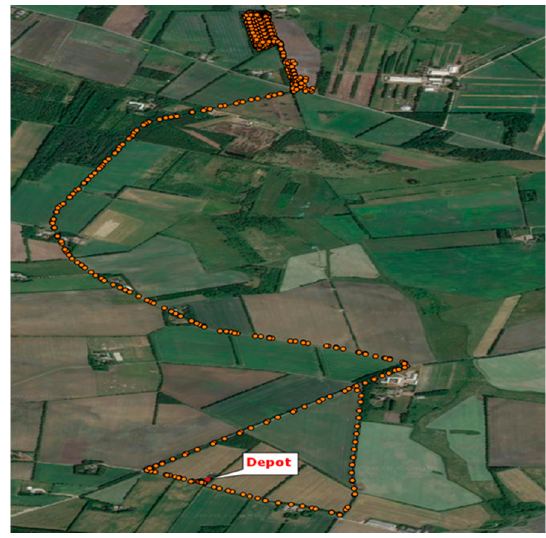
Figure 7. Case study field and the location of the depot. Table 5. Input data for the optimization and simulation models.